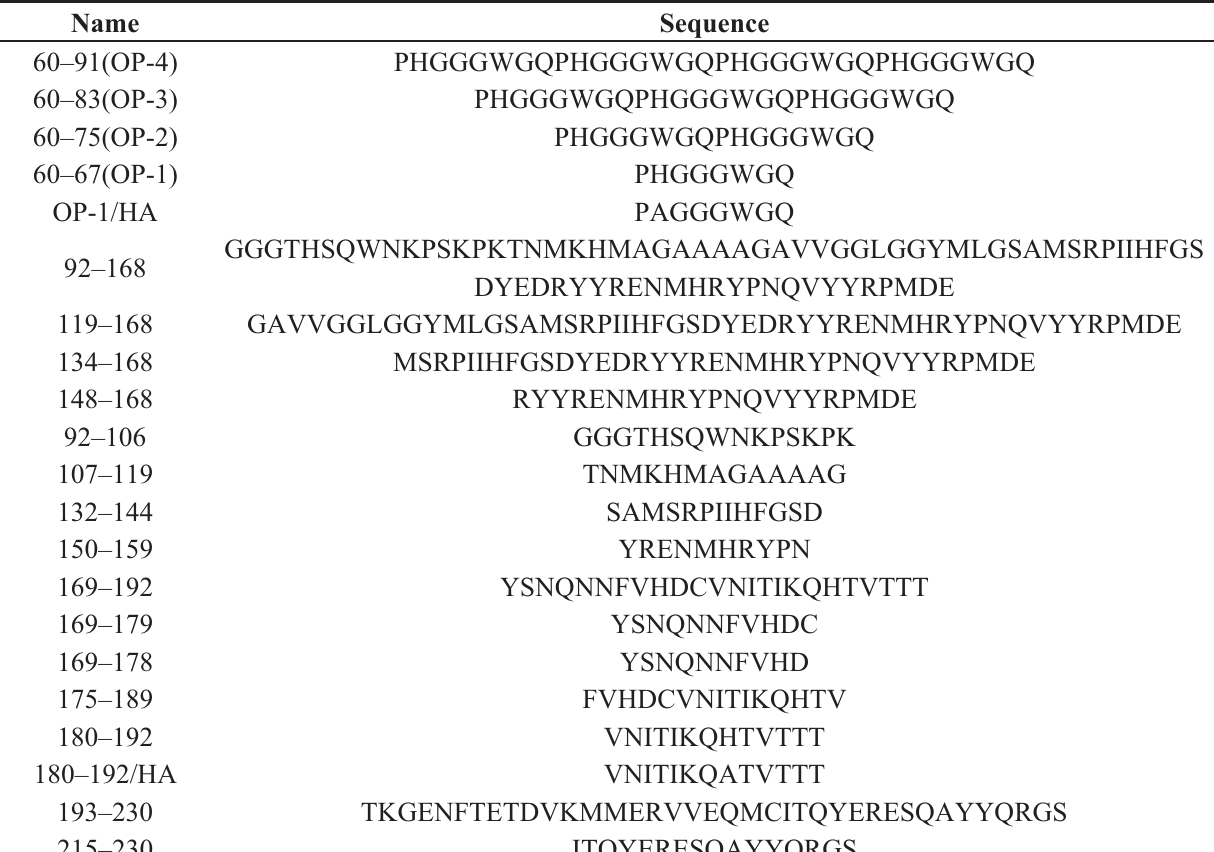
Table 1. Amino acid sequences of hPrP fragment